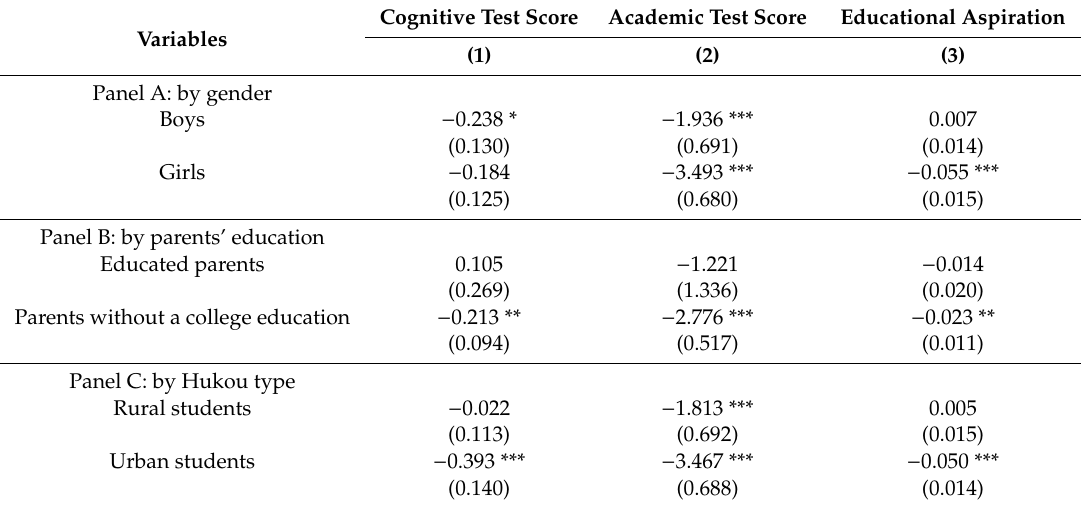
Table 7. Heterogeneous e ff ects of parental absence on student